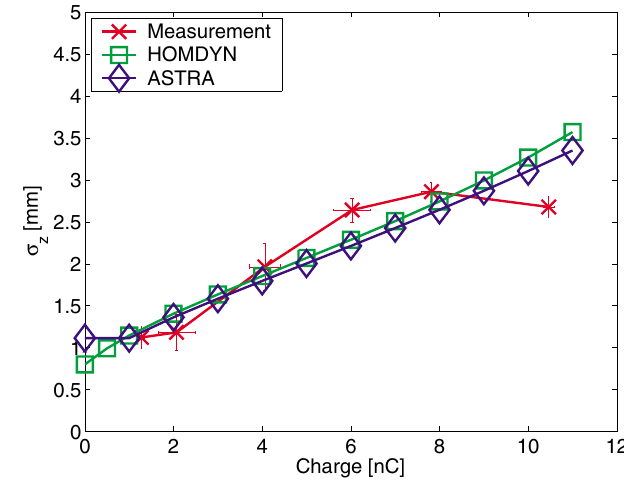
FIG. 4. (Color) Comparison of the measured and simulated bunch length as a function of the charge 1 nC beam at Fermilab, the results reported in Fig. 4 and (cid:3) (cid:9) 9 : 0 (cid:4) 0 : 6 (cid:11) (cid:13) 10 12 A = (cid:9) mm mrad (cid:11) 2 . Table I lead to B n For comparison, Ref. [30] states that the highest brightness values achieved in operating photoinjectors are of order 10 13 A = (cid:9) mm mrad (cid:11) 2 .